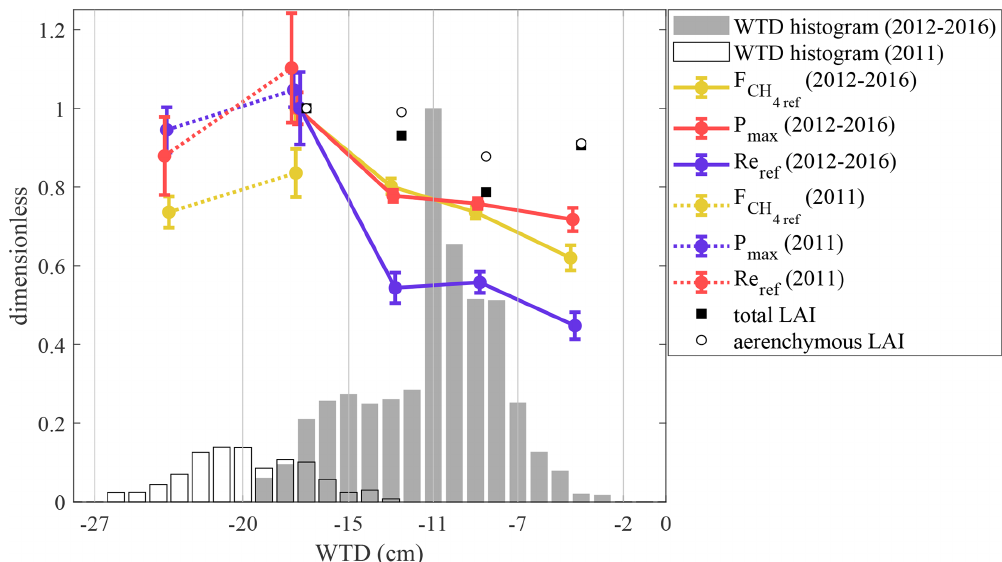
Figure 10. Reference fluxes for F CH and Re and maximum photosynthesis P max vs. water table depth, calculated as averages for the data 4 within five WTD bins (marked by vertical lines), normalized by the value of the maximum bin average, along with the corresponding air temperature and measured LAI bin averages. The 2011 data are normalized by the 2012–2016 maxima, thus yielding values above unity. The data are from the period of June–August. The uncertainty bars give 50% parameter CI. The WTD histogram is shown as gray bars. WTD histograms and flux parameters are shown separately for 2011 and 2012–2016. Table 6. Cumulative gap-filled summer and growing season CO 2 , CH 4 fluxes and their 6-year averages, in gCm − 2 . The relative uncertainty is calculated using the May–September 6-year mean cumulative fluxes as 10% for F CH , 40% for NEE, and 20% for Re and GPP. In 2013, 4 the NEE, Re and GPP uncertainties are assumed to be double due to poor CO 2 EC flux data coverage. The last column gives the average cumulative fluxes with 2011 and 2013 excluded as the years with the lowest EC data